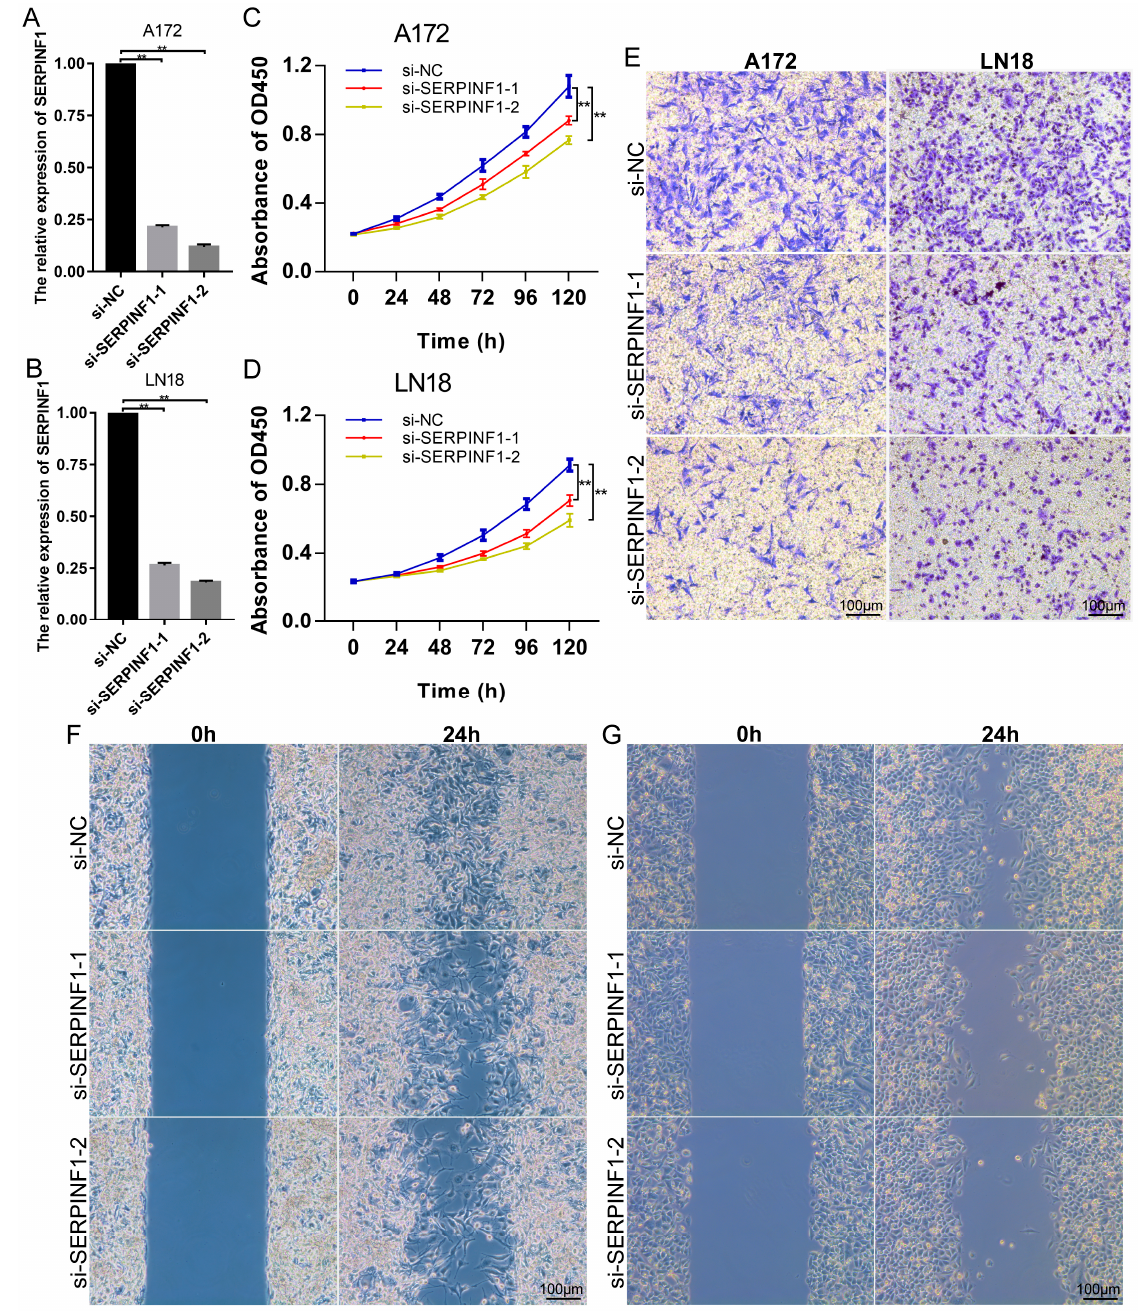
Figure 3. Effects of SERPINF1 knockdown on the proliferation and invasion of glioma cells. ( A , B ) Knockdown efficiency of SERPINF1 in A172 and LN18 verified via RT-qPCR. ( C , D ) Anti-proliferative effect of SERPINF1 knockdown on A172 and LN18 verified via CCK-8 assay. ( E ) Anti-invasive effect of SERPINF1 knockdown on A172 and LN18 verified via Transwell assay. ( F , G ) Anti-migrative effect of SERPINF1 knockdown on A172 ( F ) and LN18 ( G ) verified via migration assay. (** p < 0.01) .